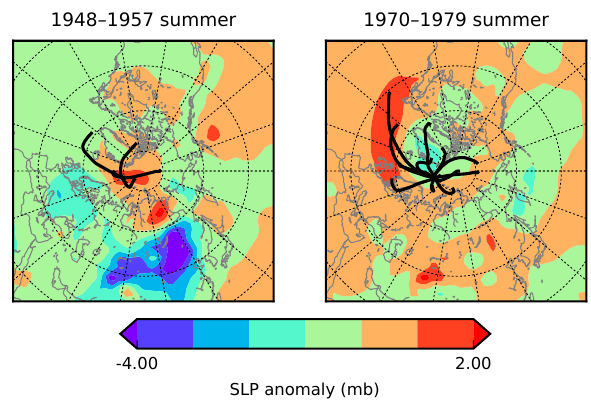
Figure 9. Ten-day clustered back trajectories starting from the Lomonosovfonna ice core location superimposed on sea level pres- sure anomalies for summer (June–August) of 1948–1957 (negative SNAO) and 1970–1979 (positive SNAO). Anomalies are relative to the 1948–2017 mean of NCEP/NCAR reanalysis